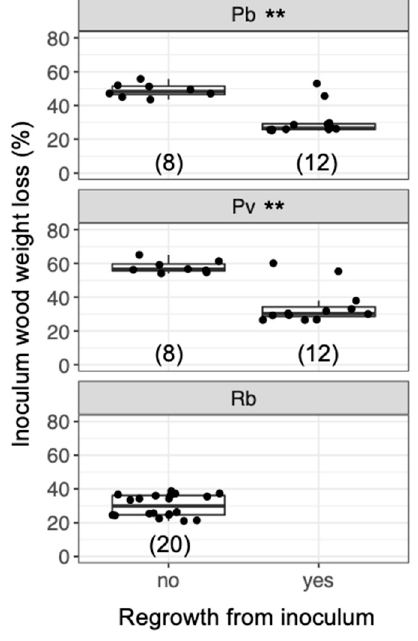
Figure 8. Weight loss of inoculum wood blocks with/without hyphal regrowth 7 d after the blocks had been transferred to new soil dishes, regardless of the timing of added bait. Abbreviations: Pb, Pholiota brunnescens ; Pv, Phanerochaete velutina ; Rb, Resinicium bicolor . Asterisks indicate significant differences between wood blocks with and without hyphal regrowth (Wilcoxon rank-sum test: ** p < 0.01). Numbers of replicates are shown in parenthesis. Balck dots are individual data. Upper and lower ends of vertical lines indicate maximum and minimum values, respectively. The tick horizontal line indicates median.